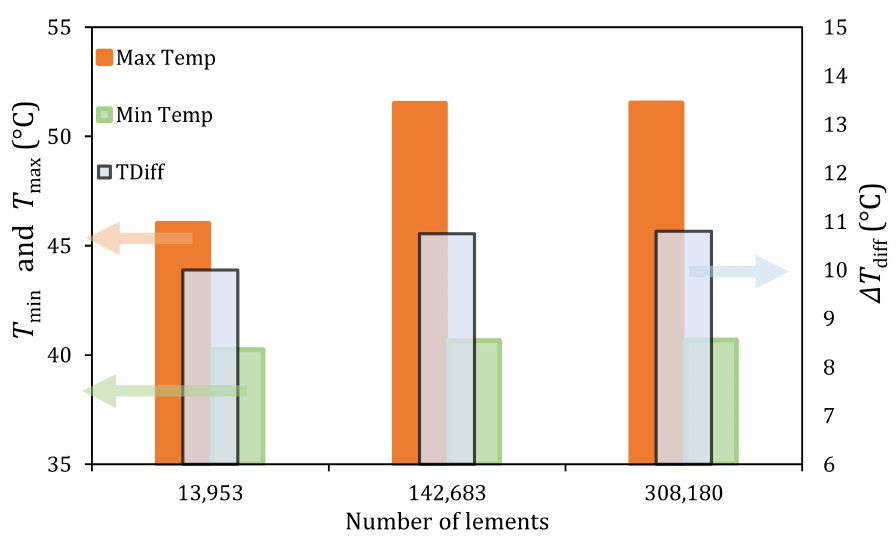
Figure 3. Temperatures across the battery cell and fluid domains versus number of elements, showing the maximum and minimum temperatures and temperature